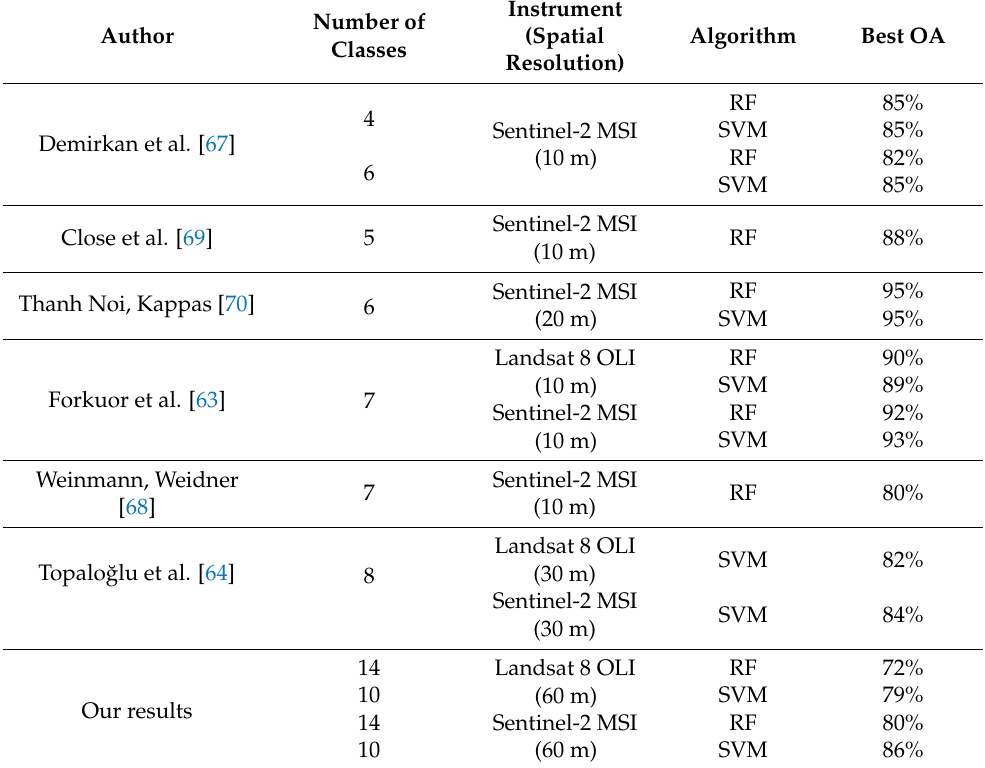
Table 13. Comparison of the obtained results with the